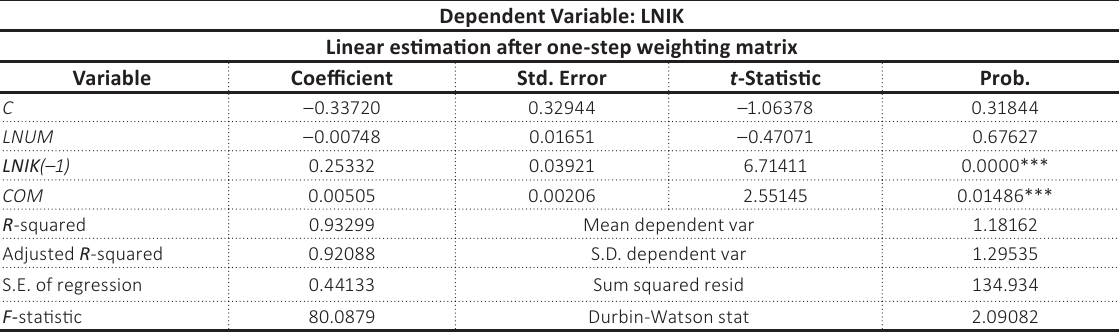
Table 4. Structural attributes of firms and corporate investment